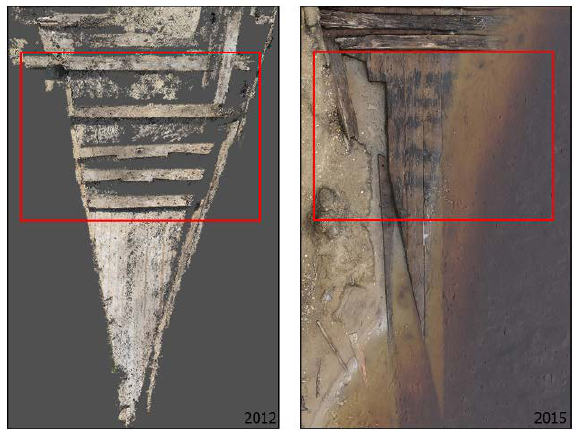
Figure 5. Reconstruction of the missing ship